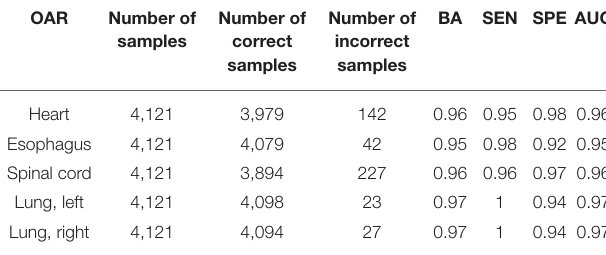
TABLE 2 | Quantitative evaluation of the contouring error